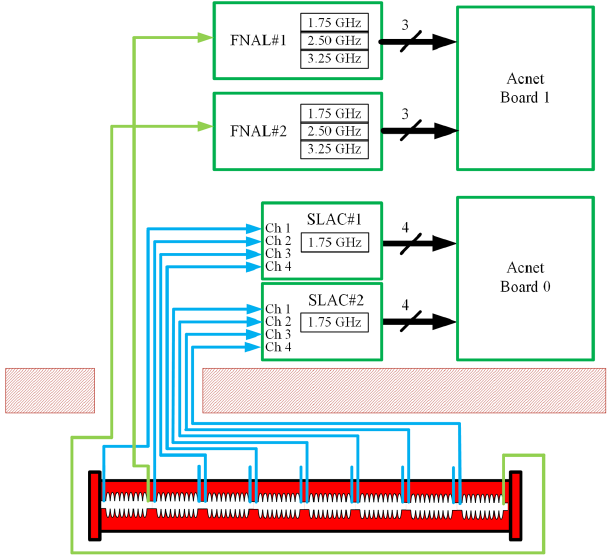
FIG. 3. Schematic of eight channels from the US couplers of eight cavities plus FNAL channels on C1 and C8 DS channels going into the digitizer boards [8].